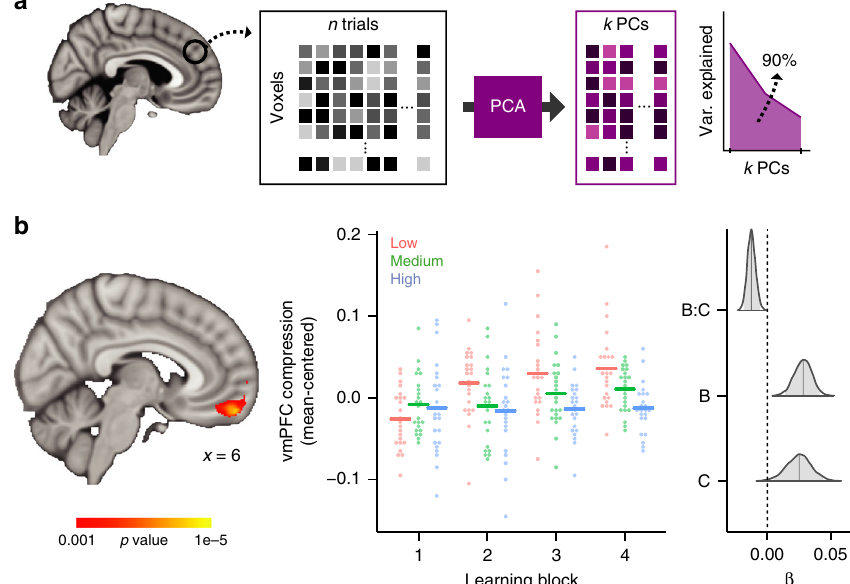
Fig. 2 Neural compression analysis schematic and results ( N = 23). a Principal component analysis (PCA) was performed on neural patterns evoked for each of n trials within a learning block. The number of principal components (PC) required to explain 90% of the variance ( k ) was used to calculate a neural compression score (1- k / n ). We quanti fi ed neural compression as a function of problem complexity and learning block; the interaction of these factors re fl ects changes in the complexity of neural representations that emerge with learning. b A whole-brain voxel-wise linear mixed effects regression revealed a vmPFC region that showed a signi fi cant interaction between learning block and problem complexity. See Supplementary Figure 1 for main effect maps of learning block and problem complexity. The nature of the interaction in the vmPFC region is depicted in the middle panel; points represent compression at the cluster ’ s peak voxel for each participant and the horizontal lines depict the group average. The right graph plots the results of a Bayesian-estimated linear mixed effects regression of neural compression from the peak voxel of the vmPFC cluster. Posterior distributions of coef fi cients from the regression model are depicted for the factors of learning block ( b ), complexity ( c ), and their interaction ( b : c ). Shaded regions within the distributions represent 95% high-density intervals. These data and regression results are displayed only to demonstrate the nature of the interaction effect in the vmPFC cluster and do not represent an independent statistical